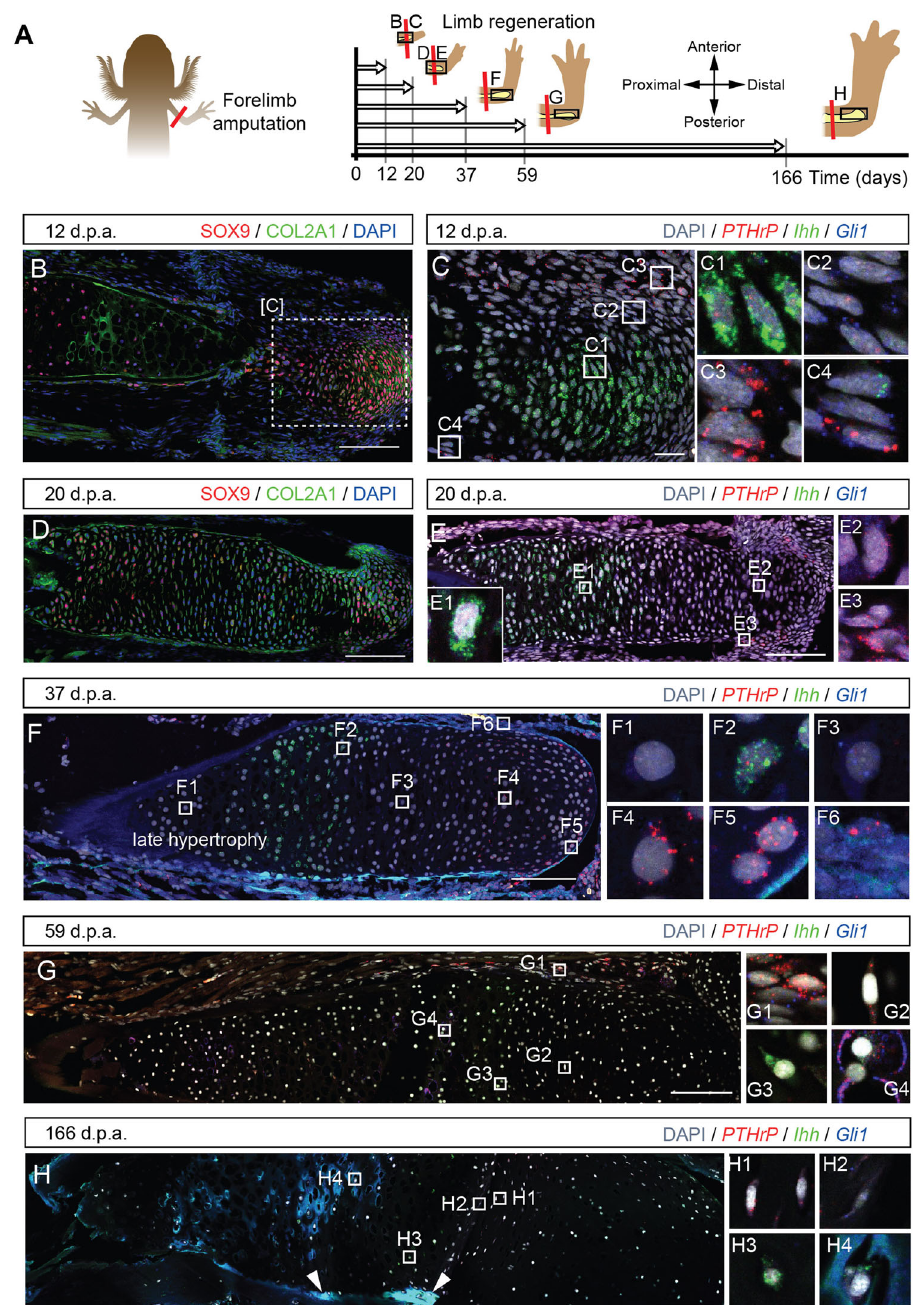
Fig.6|DynamicexpressionofthePTHrP-Ihhloopcomponentsduringskeletal regeneration.A Experimentaloutlineforassessmentofthe PTHrP-Ihh loopduring regeneration in Pleurodeles waltl . Larvae at stage 54 underwent unilateral ampu- tations. The regenerating limbs and contralateral controls were collected at the selectedtime points. Note thatthe axis drawn inA appliesto allthe pictures ofthe regeneratinghumerusinthe fi gure( B – H ). B At12dayspost-amputation(d.p.a.),the coreoftheblastemashowedSOX9 + /Col2A1 + emergingchondrocytes. C At12d.p.a., a central group of Ihh + (C1) is wrapped by a layer of Gli1 + (C2) cells followed by a layer of PTHrP + cells (C3). This pattern was also observed in periskeletal cells